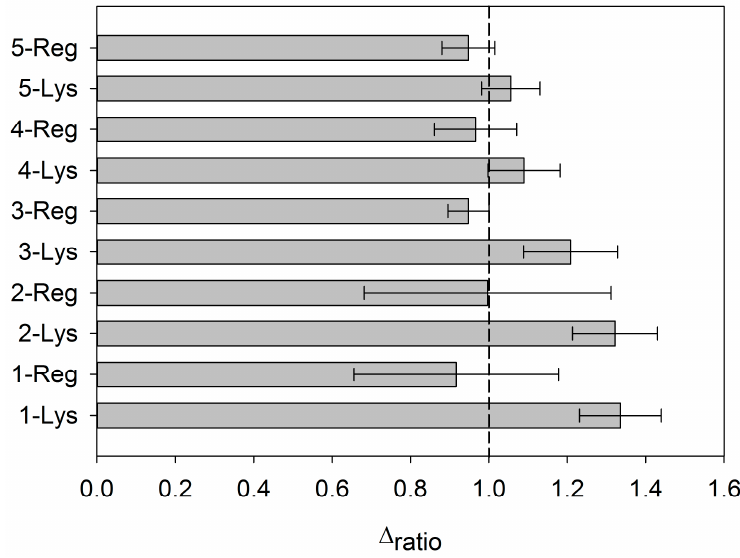
Figure 7. Δ ratio values for five consecutive cycles of regeneration. The concentration of Lys employed is 2 µM. The deviation is calculated for n = 5 replicates.